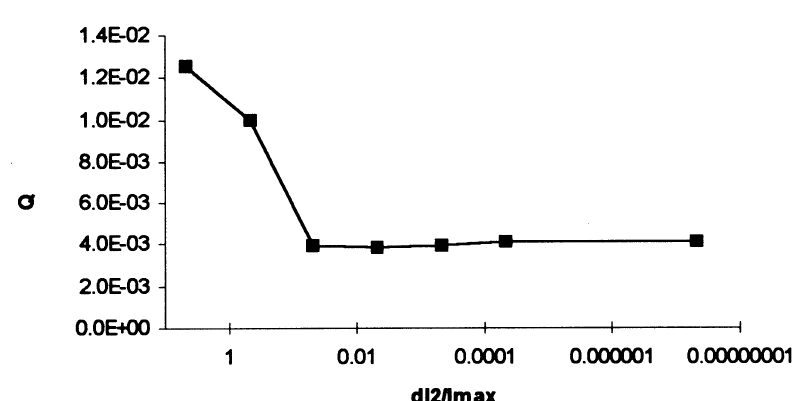
FIGURE 1 Q function versus the ratio d I 2 = I max for the emitter-base junction characteristic of a 2N2904A transistor.